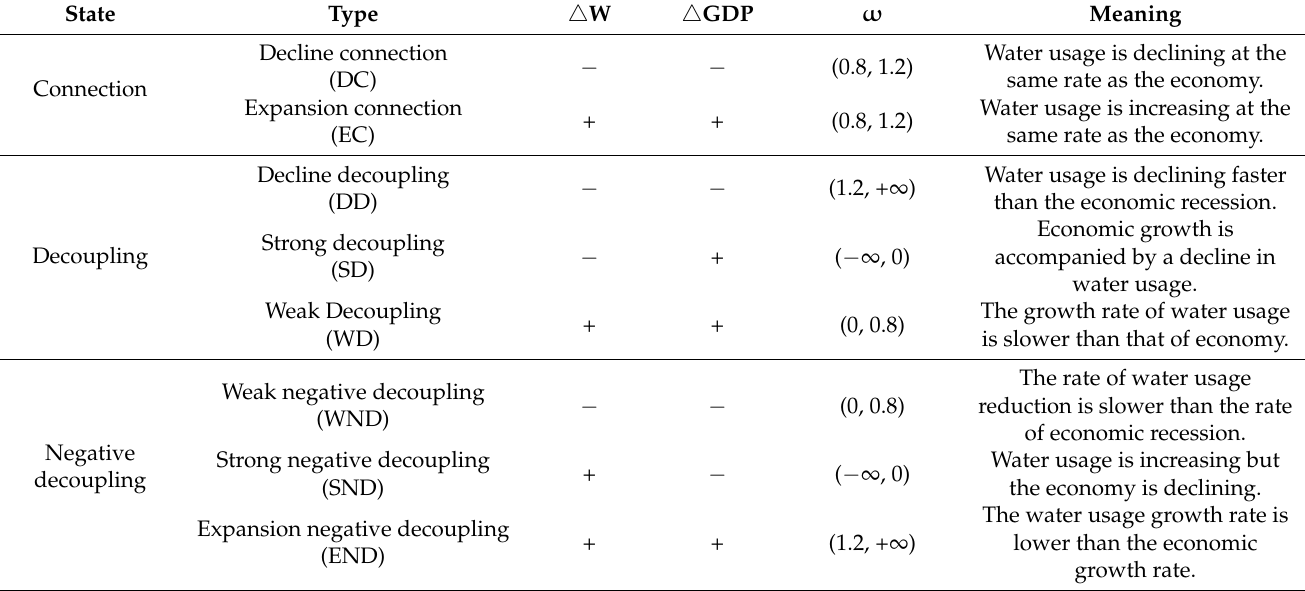
Table 1. Types of Tapio